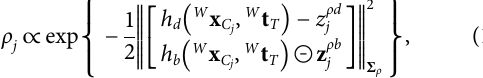
Frontiers in Robotics and AI |